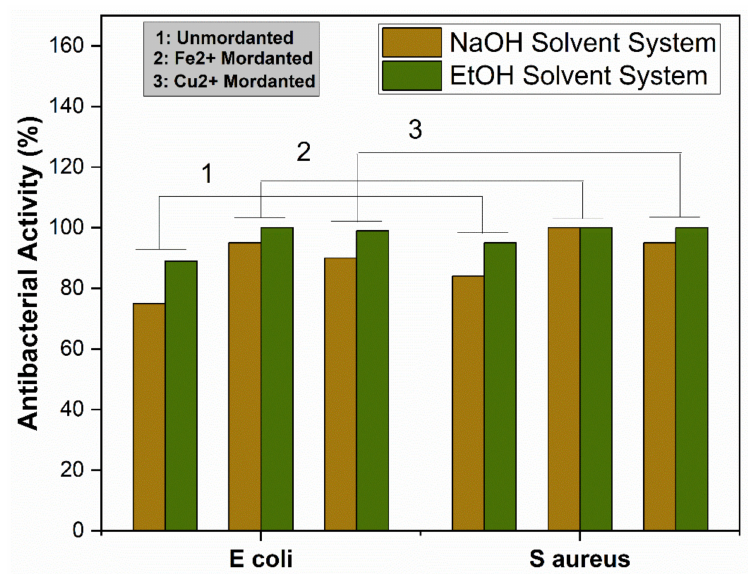
Figure 10. Antibacterial activity of unmordanted and mordanted dyed fabrics.